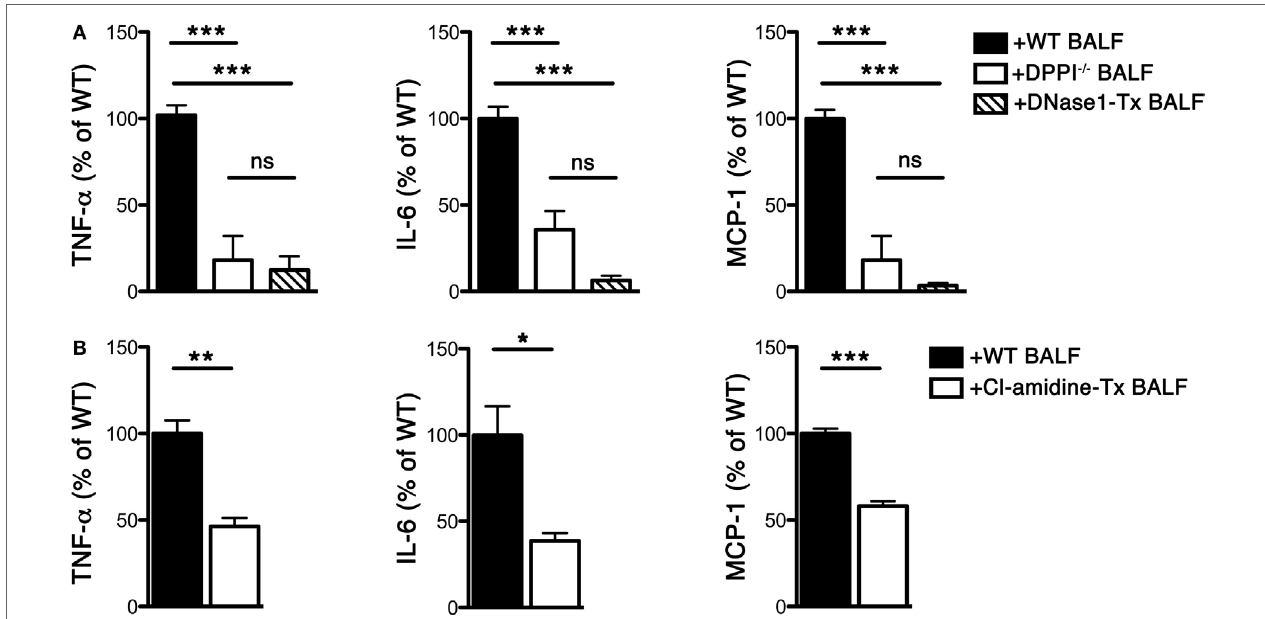
FigUre 6 | BalF from sev-infected mice stimulates cytokine release from BMDcs . WT and DPPI − / − mice were infected with Sev on day 0. Some WT mice were treated i.n. with DNase 1 or Cl-amidine as detailed in Section “Materials and Methods.” BALF was harvested on day 3 PI and cells were pelleted. The cell-free BALF from each genotype/treatment was added to BMDCs at a final dilution of 44%. The supernatant was collected after 48 h and assayed for cytokine levels with CBA. (a) Cytokine levels from co-cultures of BMDCs with BALF from WT, DPPI − / − , or DNase 1-treated (Tx) mice. (B) Cytokine levels from co-cultures of BMDCs with BALF from Cl-amidine-treated mice. Values represent mean ± SEM, n = 4–6 mice/treatment group. The mean of WT cytokine levels for each experimental condition was set at 100%; values are expressed as% of mean WT level. * P < 0.05, ** P < 0.01, *** P < 0.001, ns = not